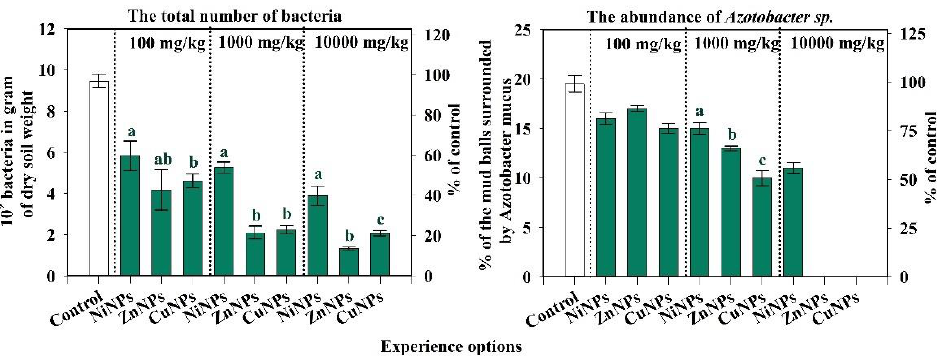
Figure 1. Changes in the total number of bacteria and Azotobacter sp. abundance of Cambisols by Cu, Ni, and ZnNPs pollution. Note: Different letters indicate significant differences ( p < 0.05) between the content of nickel, zinc, and copper nanoparticles at the same dose of their introduction into the soil, obtained as a result of the Student’s test. The absence of bands in the graph indicates the non-viability of the abundance of Azotobacter sp. with the introduction of 10,000 mg/kg of zinc and copper nanoparticles into the soil.